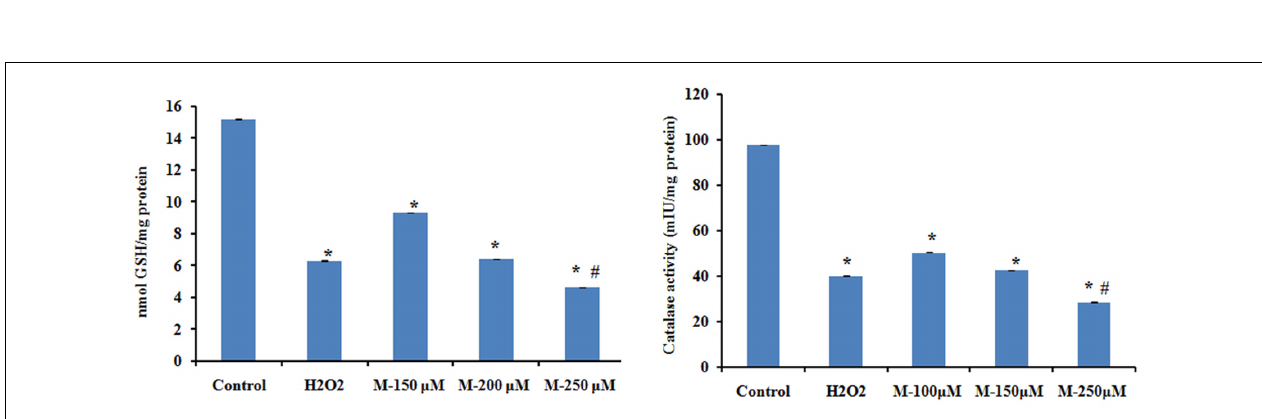
FIGURE 8 | The levels of reduced glutathione and catalase activity were assayed after treatment with of morin (150, 200, and 250 µ M) for 48 h and H 2 O 2 (200 µ M) for 2 h. Each value represents mean ± SD (standard deviation) from triplicate measurements. CAPT: camptothecin (50 µ M), M (150, 200, and 250 µ M): Morin (150, 200, and 250 µ M). Significance levels between different groups were determined by using one way ANOVA, followed by Duncan’s multiple range test. ∗ p ≤ 0.05 versus control, # p ≤ 0.05 versus camptothecin.